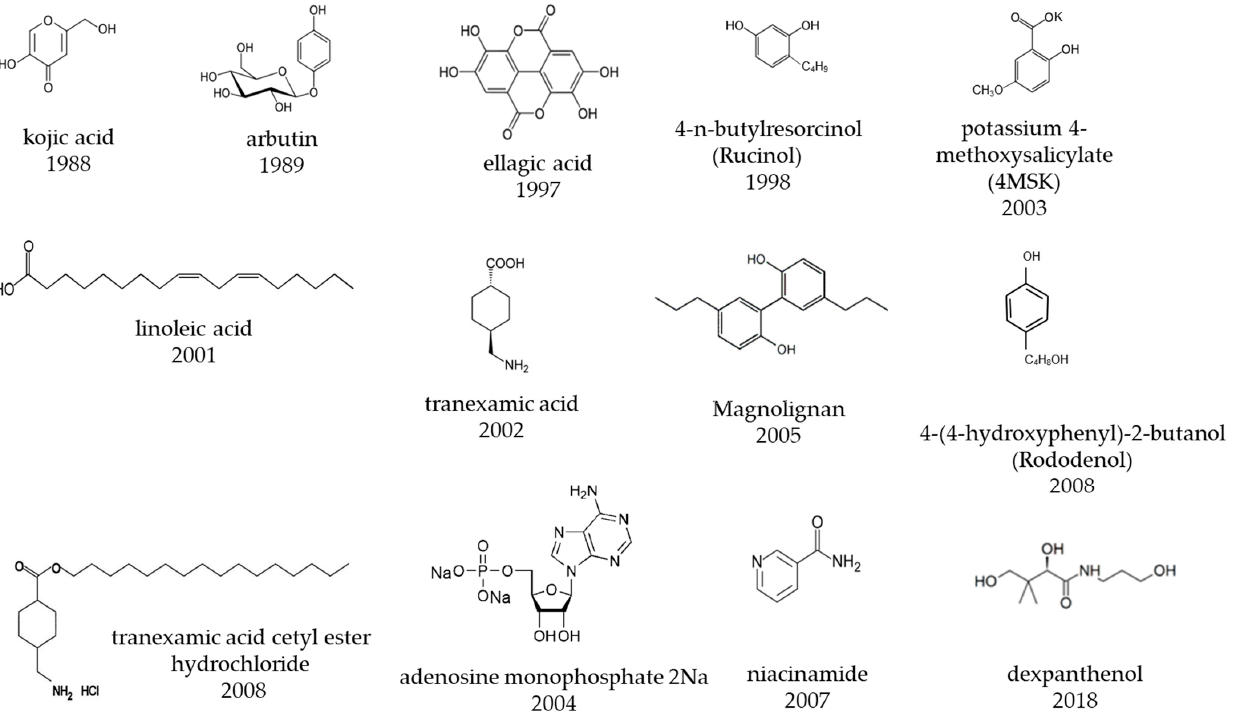
Figure 1. Chemical structure of skin-lightening active ingredients in Japan.